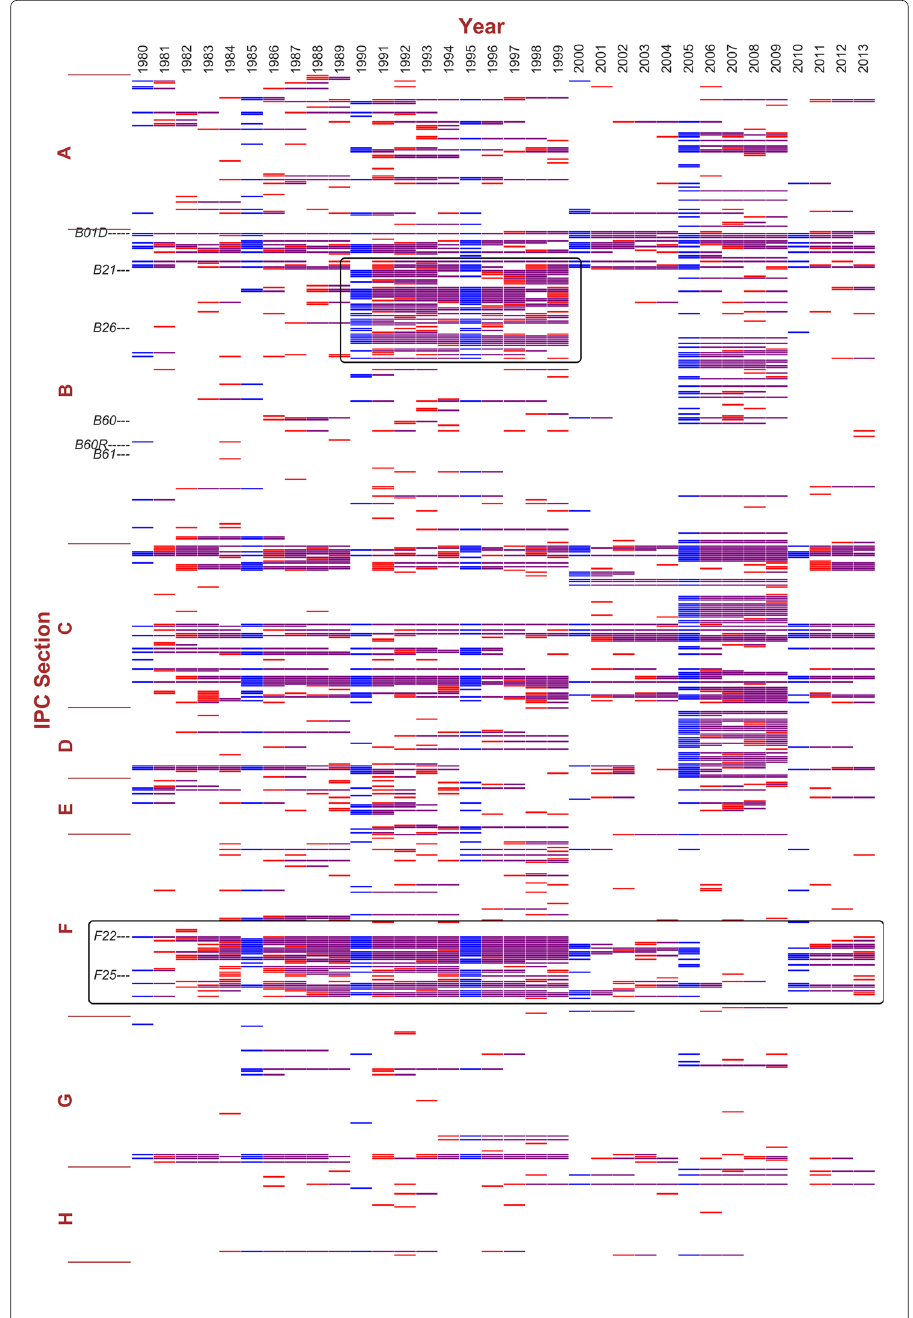
Fig. 5 Tracking community B01D in consecutive 5-year time windows, mapping to the previous year. The x-axis indicates years from 1980 to 2013, and the y-axis indicates the nodes, i.e. IPC subclasses, ordered in IPC index. The community mapping is based on consecutive 5-year windows. In each time window, the initial year’s community containing the central node set represented by B01D is shown in blue. In the rest 4 years, colored nodes represent the mapping communities: red indicates the node does not exist in the reference community (community of the previous year), and purple indicates the overlapping